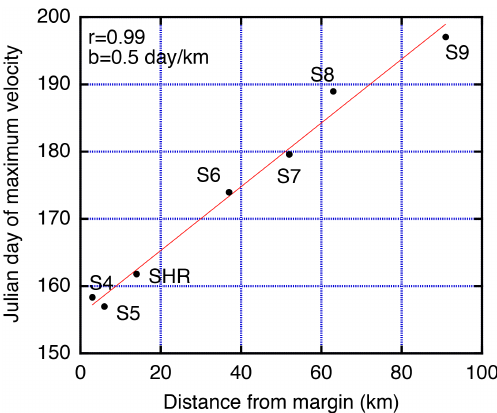
Figure 4. The progression of the early spring event up-glacier. Data are averaged over the period